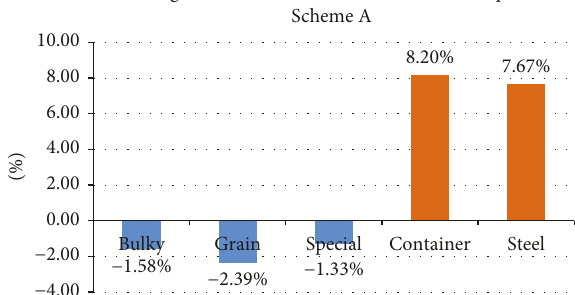
Figure 25: Differences of MDTCY between Scheme A and Scheme